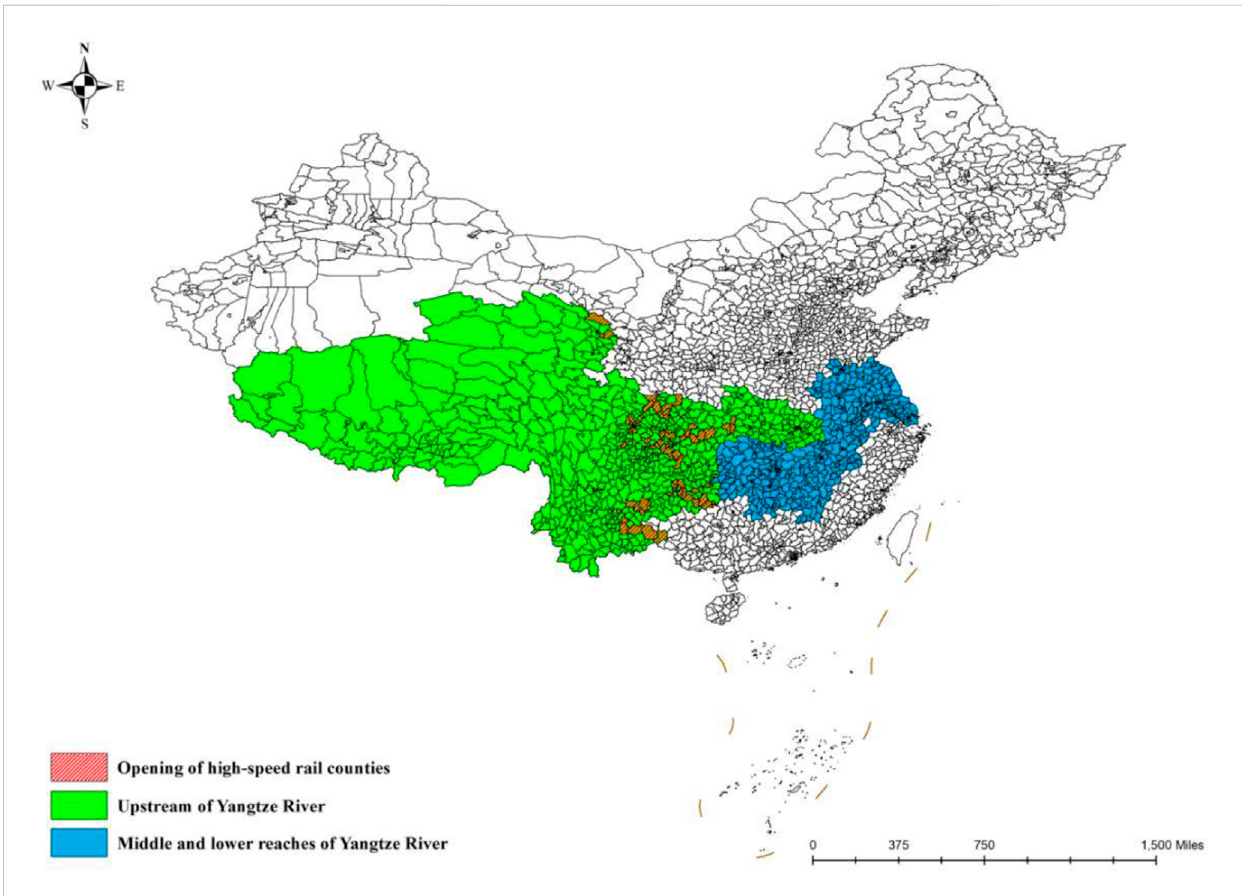
FIGURE 2 A map of the investigated area in shallow green color.